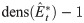
Observed mean of dominance and robustness and density of 5 networks as the networks grows in size over time.To improve the presentation, we plot dens(E^t*)−1 for the density measure.